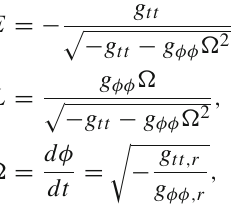
Fig. 15 Image of a thin spherical shell with radius r = r + = 5 . 896 M in the spacetime of the strongly naked singularity with γ = 0 .